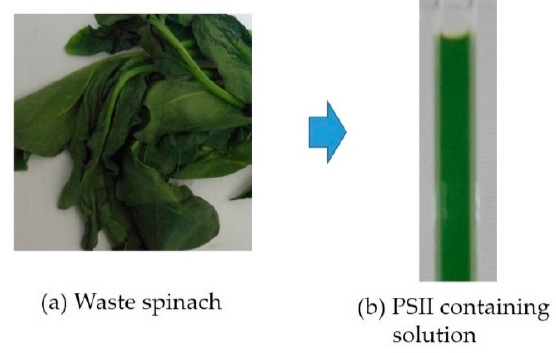
Figure 4. Extract of the PSII-containing solution. The concentration was adjusted so that the chlorophyll concentration reached 15.6 µ